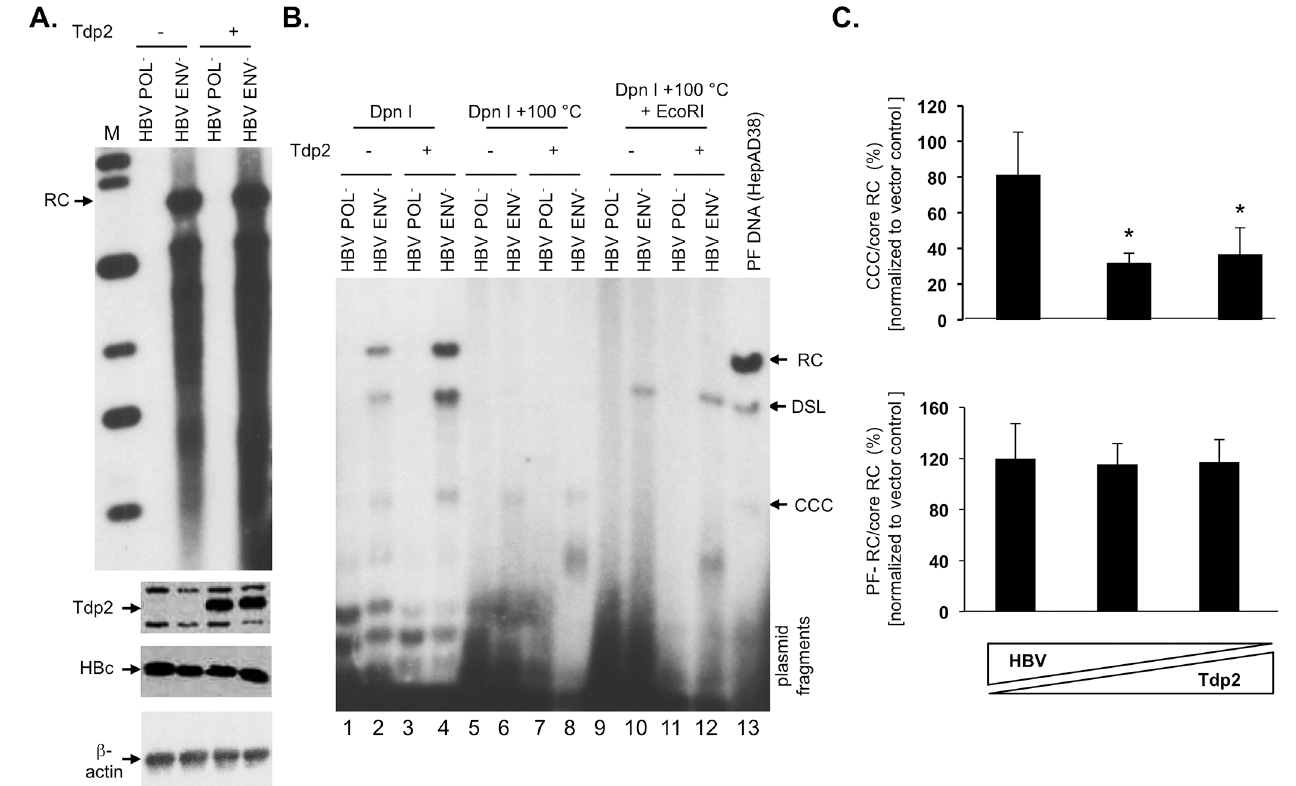
Fig 4. Overexpression of Tdp2 was associated with a decrease in HBV CCC DNA. (A) and (B). HEK293 cells in 6 cm dishes were cotransfected with the envelope-defective HBV (5 μ g) and Tdp2 (+) or empty vector (-) (5 μ g) plasmid. Five days post-transfection the cells were harvested and analyzed for protein expression and viral DNA levels. (A) HBV core DNA was extracted and analyzed by Southern blotting (top panel). Tdp2 and HBc levels were measure by western blotting (2nd and 3rd panels). β - actin was measured by western blotting as a loaded control (4 th panel). (B) HBV PF DNA were extracted and analyzed by Southern blotting. PF DNA samples were Dpn I-digested to degrade plasmid DNA (lanes 1 – 4). Plasmid fragments at the bottom of the agarose gel are indicated. To further verify the identity of CCC DNA, the Dpn I digests were boiled to reduce RC and double-stranded linear (DSL) DNA species (as well as plasmid fragments) to single strands whereas the supercoiled CCC DNA remained circular (lanes 5 – 8), or boiled and then digested to linearize the CCC DNA (lanes 9 – 12). PF DNA extracted from HepAD38 cells was loaded in lane 13 as a positive control for the mobility of the RC, DSL, and CCC DNA species. (C) Quantitative analysis of HBV core and PF DNA. The triangles at the bottom represent the graded amounts of HBV and Tdp2 (+) or empty vector (-) plasmid: left bar, 7.5 μ g HBV plasmid and 2.5 μ g Tdp2 (+) or empty vector (-) plasmid; middle bar, 5 μ g each HBV and Tdp2 (+) or empty vector (-) plasmid; right bar, 2.5 μ g HBV plasmid and 7.5 μ g Tdp2 (+) or empty vector (-) plasmid. The indicated viral DNA ratios were normalized to the corresponding DNA ratios from empty vector transfection (set to 100%) and are reported as the mean relative ratios ± standard error of the mean of three independent experiments. The asterisks ( * ) indicate a significant difference in CCC/core RC at HBV:Tdp2 plasmid transfection ratios of 5 μ g: 5 μ g and 2.5 μ g: 7.5 μ g, compared to corresponding HBV:empty vector transfections (P < 0.05; unpaired, two-tailed t-test). CCC, CCC DNA; DSL, DSL DNA; RC, RC